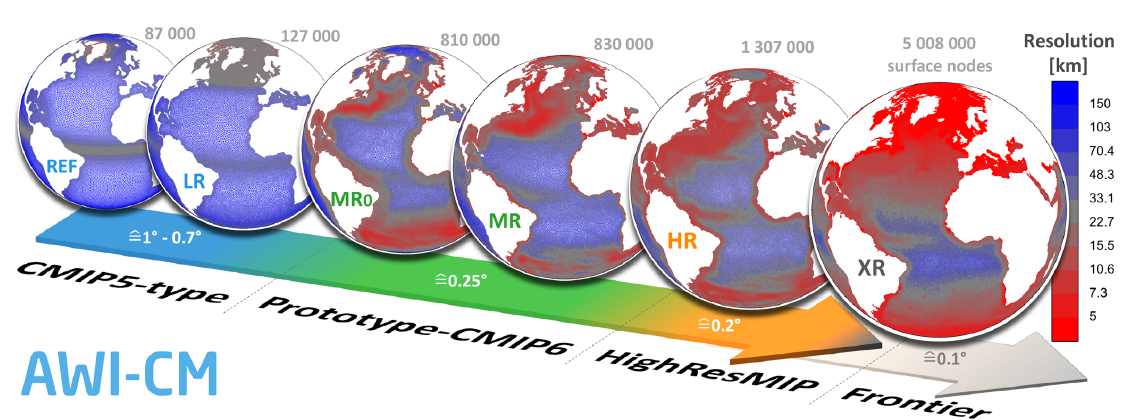
Figure 2. Hierarchy of a set of different ocean grid resolutions that are used in this study. The number of surface grid points increases from left to right and, specifically, the spatial resolution in the North Atlantic Ocean increases from REF up to the frontier mesh (XR). REF and LR use CMIP5-type spatial resolution, with moderate refinement to about 25km in the tropics and in the Arctic (Rackow et al., 2018a; Sidorenko et al., 2011). MR0, MR, and HR are medium- and high-resolution meshes, following a different mesh design strategy (Sein et al., 2016), and focus on the Agulhas and North Atlantic current region. The resolution of XR additionally follows the local Rossby radius of deformation and is capped at 4km (7km) in the Arctic (Antarctic) (Sein et al., 2017). White numbers indicate the approximate spatial resolution of corresponding quasi-Mercator grids with the same number of (wet) surface nodes. The GM parameterization is switched off within the red areas ( ≤